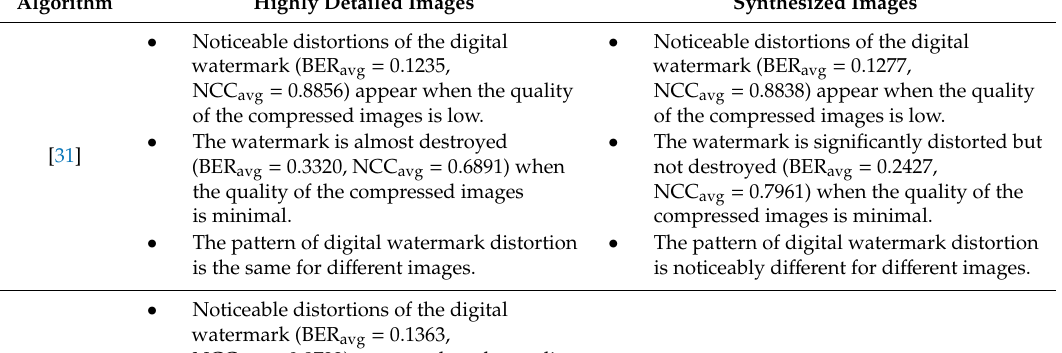
Table 6. Comparison of compression resistance of the selected algorithms.